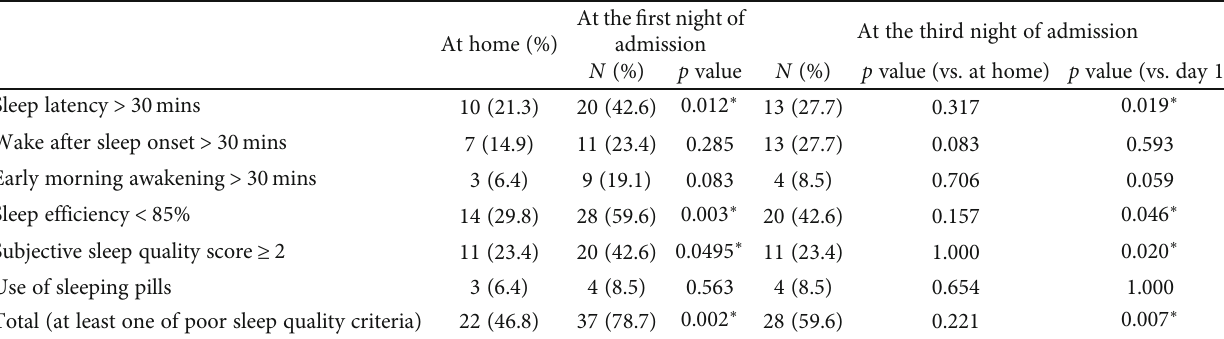
Table 4: Prevalence of poor sleep quality (special ward and private